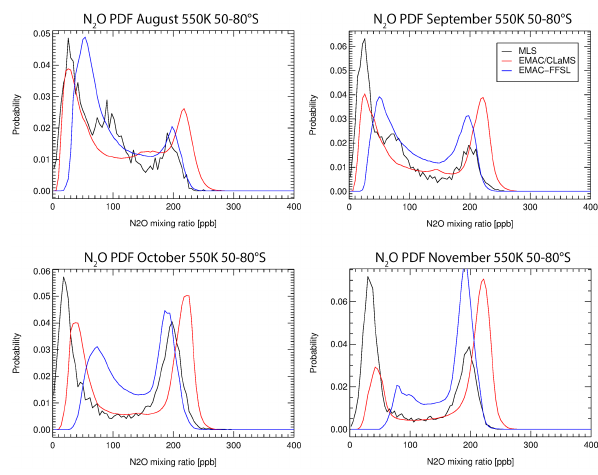
Figure 6. PDF at 550K for N 2 O mixing ratio from 50–80 ◦ S for the months August to November. Blue lines show EMAC-FFSL simu- lations, red lines EMAC/CLaMS simulations, and black lines rep- resent MLS